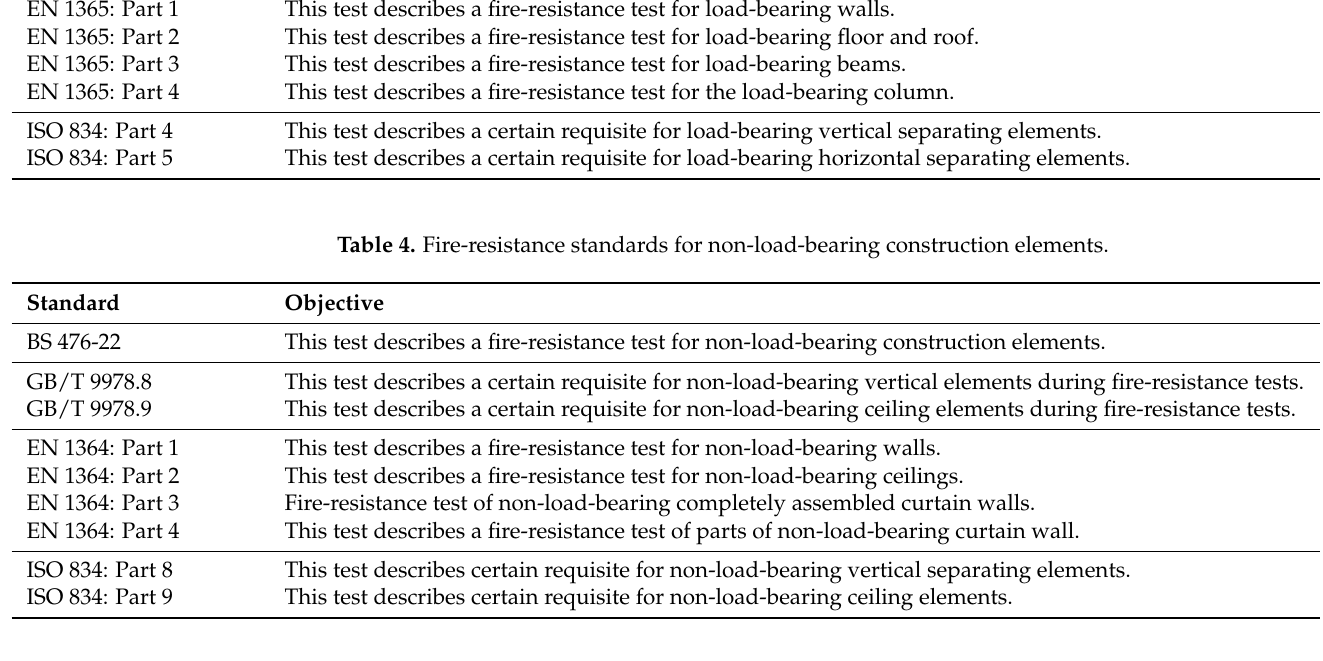
Table 5. Fire-resistance test standard for some other miscellaneous